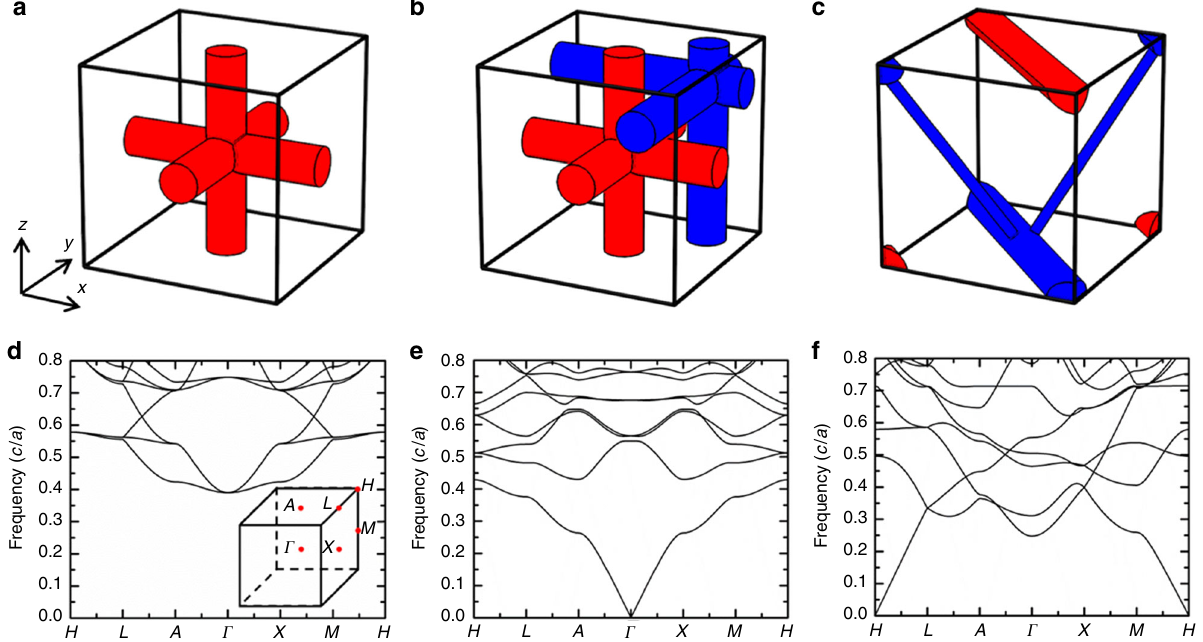
Fig. 1 Three types of wire mesh metamaterials. All have a simple cubic lattice with lattice constants of a . a Unit cell composing of a single wire mesh. b Unit cell containing two wire meshes. Compared with a , another wire mesh (blue) is added, whose node is centered at ð 0 : 3 a 0 : 3 a 0 : 3 a Þ . c A more complex metamaterial composing of two wire meshes. All of the metallic wires (both red and blue) in a – c are assumed to be perfect metal. Their different colors indicate that the two meshes have independent potentials. d – f Corresponding band structures. The single wire mesh structure d has no eigenmode at zero frequency, while the two types of double wire mesh structures have a light cone at Brillouin zone center e or corner f . The inset in d shows the